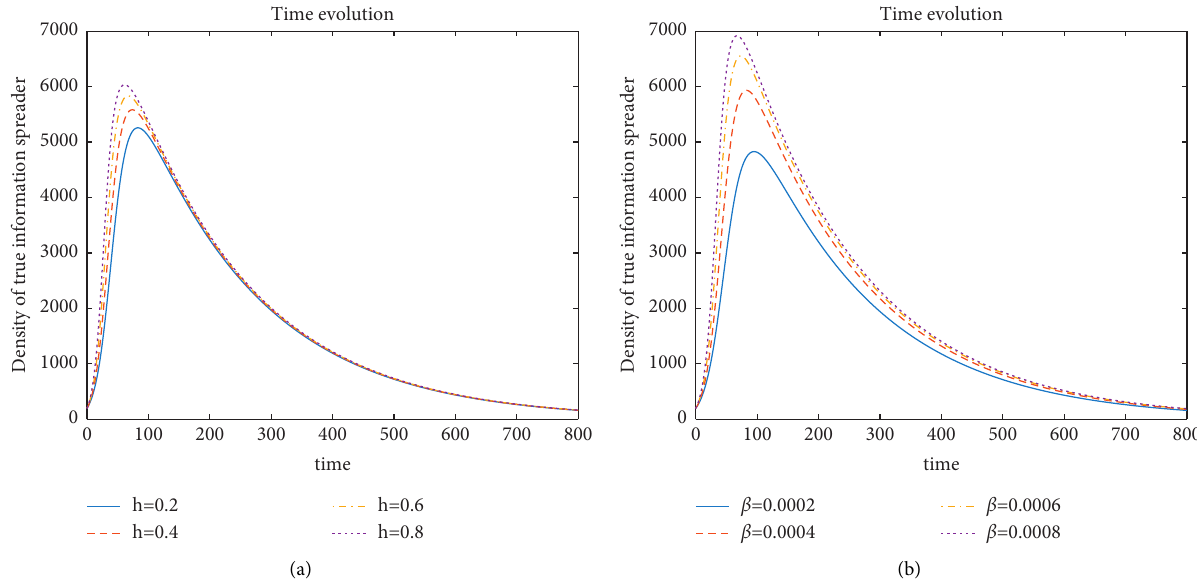
Figure 4: The impact of different parameters h , β on the density of true information spreader without